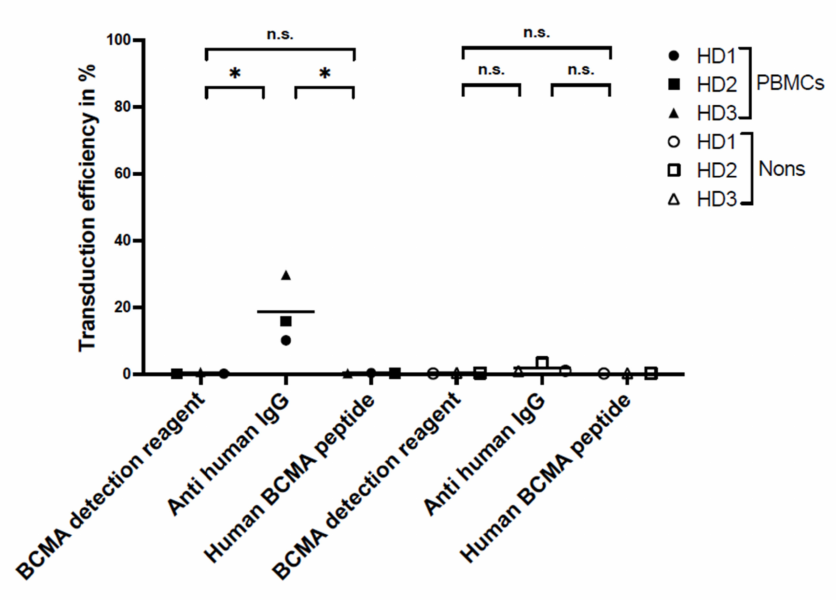
Figure 3. Specificity, i.e., background staining of non-transduced T cells from BCMA-CAR-T-cell manufacturing runs and fresh PBMCs of three HDs. Three staining reagents for the flow-cytometric analysis of transduction efficiency were compared, each one used on PBMCs and non-transduced T cells (Nons) (n.s. > 0.05, no significance, * p < 0.05, significant difference). The plot shows the mean values and statistical analysis with unpaired t